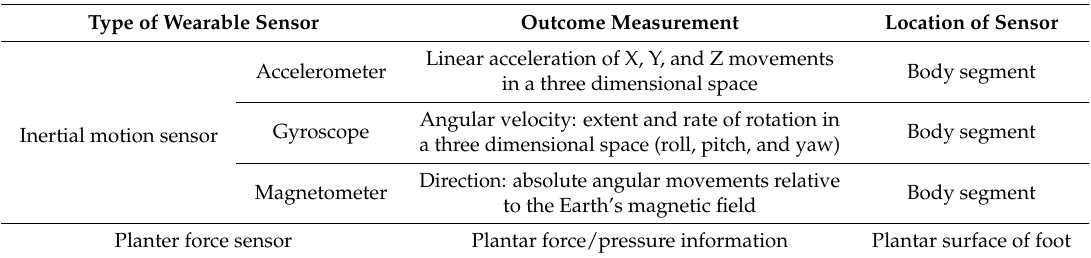
Table 1. Overview of the sensing mechanism of wearable